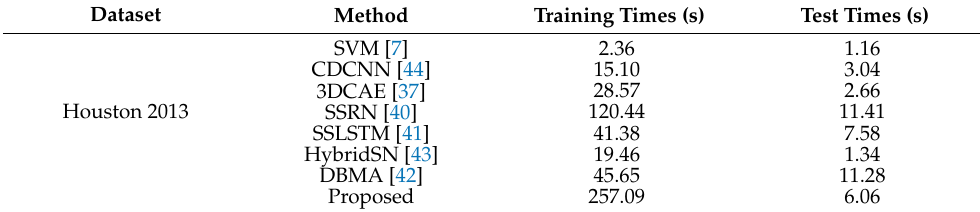
Table 14. Training and testing time of on the Houston 2013